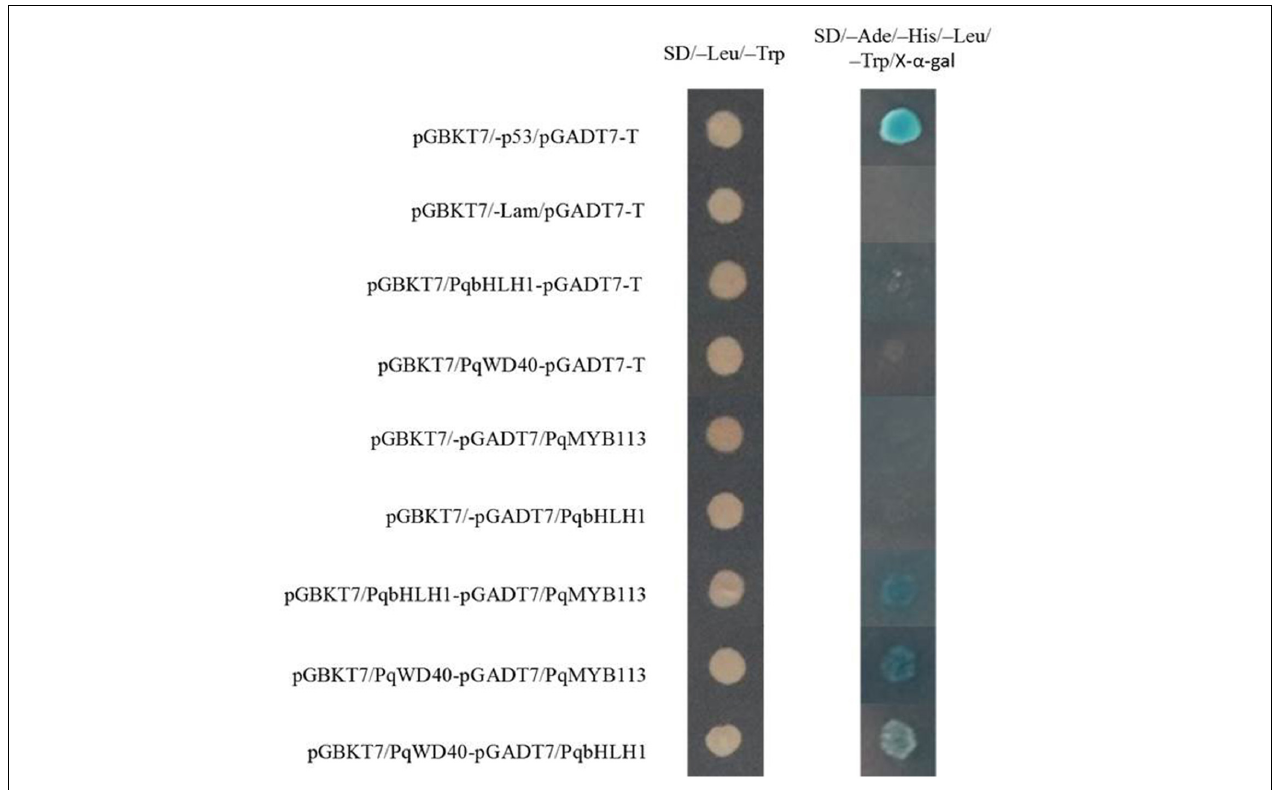
FIGURE 10 | The interaction between PqMYB113 and PqbHLH1, PqWD40 in the yeast two-hybrid system. pGBKT7-53/pGADT7-T served as a positive control; pGBKT7/-Lam/pGADT7-T served as a negative